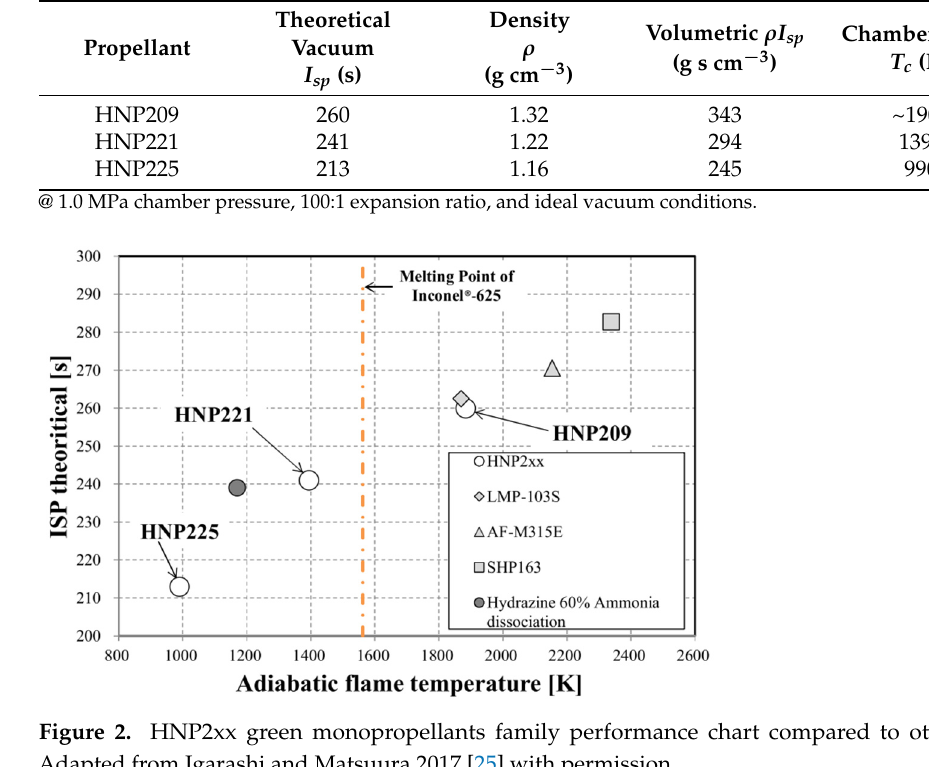
Table 4. Performance and physical properties of HNP2xx green monopropellants family [25] as cited in [27].